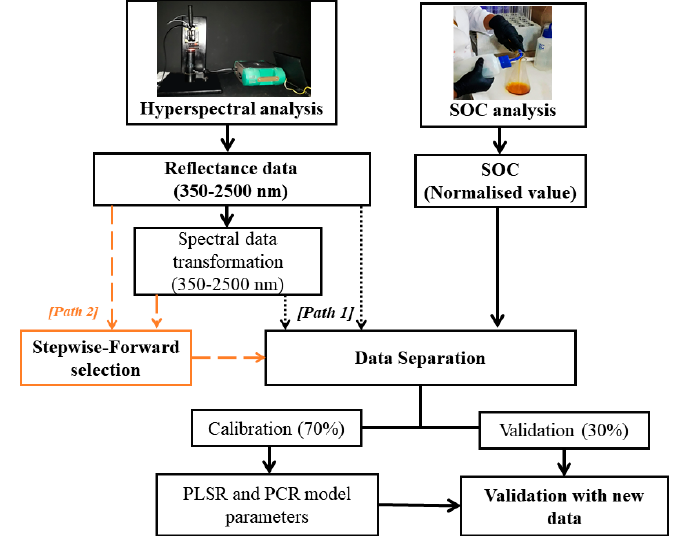
Figure 5. Workflow for estimating soil organic carbon. From each working set of data, 70% of the soil samples were selected for model calibration, while the remaining 30% were separated for the validation phase, according to Bushong et al. [67], obtaining the A1 & A2 calibration and validation sets by aggregating the respective sets of samples. A specific model was constructed for each dataset (A1; A2; A1 & A2) and for each spectral